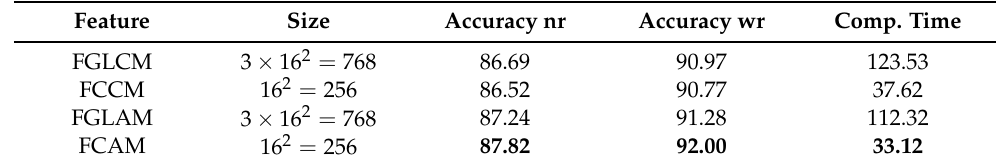
Table 2. Average accuracy (%) and computation time (s) for different fuzzy features on the Prague dataset. “nr” means no segmentation refinement, and “wr” means with segmentation refinement. Feature Size Accuracy nr Accuracy wr Comp.